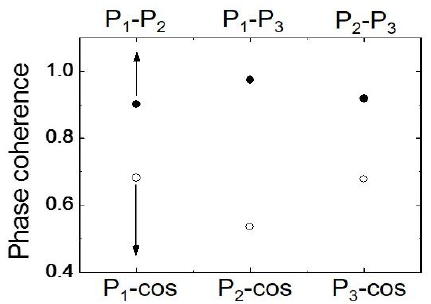
Figure 9. PC between couples of active powers (full circles) and between a given active power and the cosine function (empty circles).